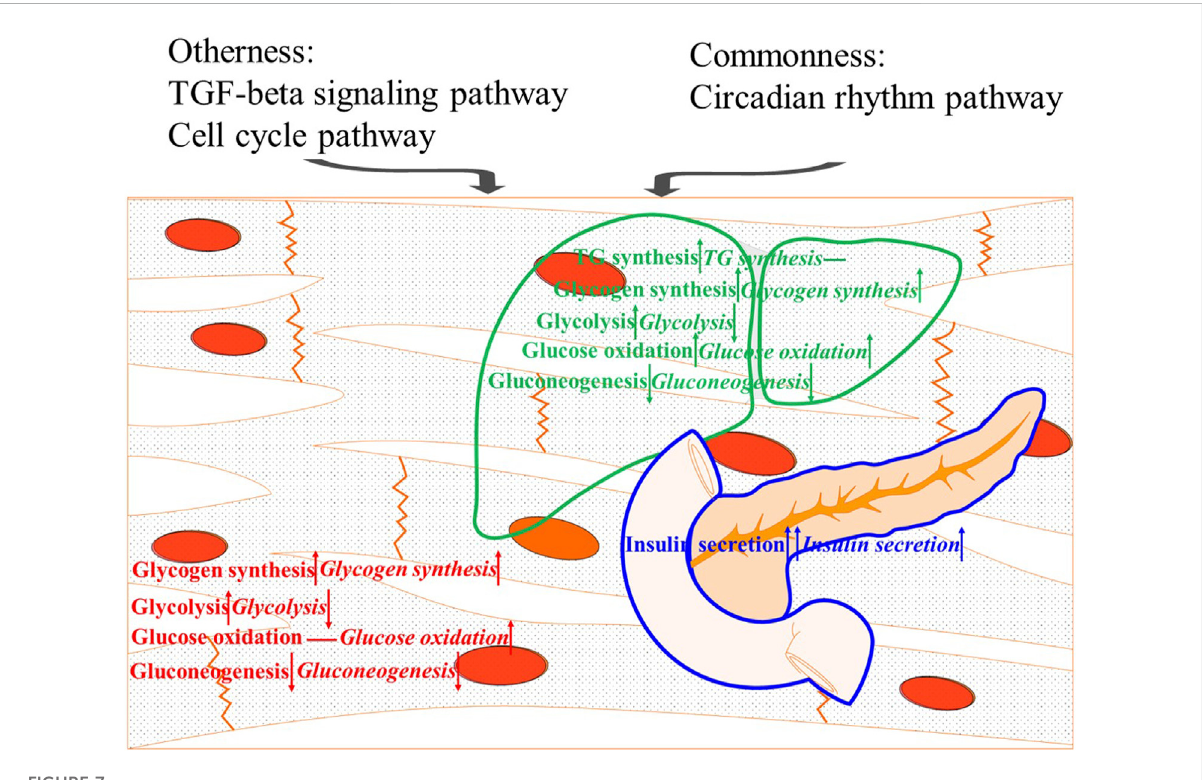
FIGURE 7 Summary diagram of the results. The upward arrow, downward arrow, and horizontal line means a positive effect, a negative effect, and no effect on resisting hyperglycemia,